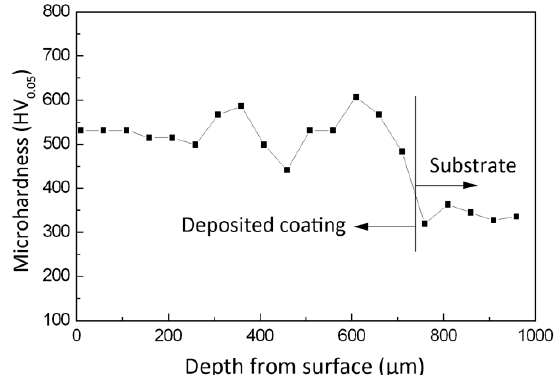
Figure 10. Microhardness distribution along the depth direction.